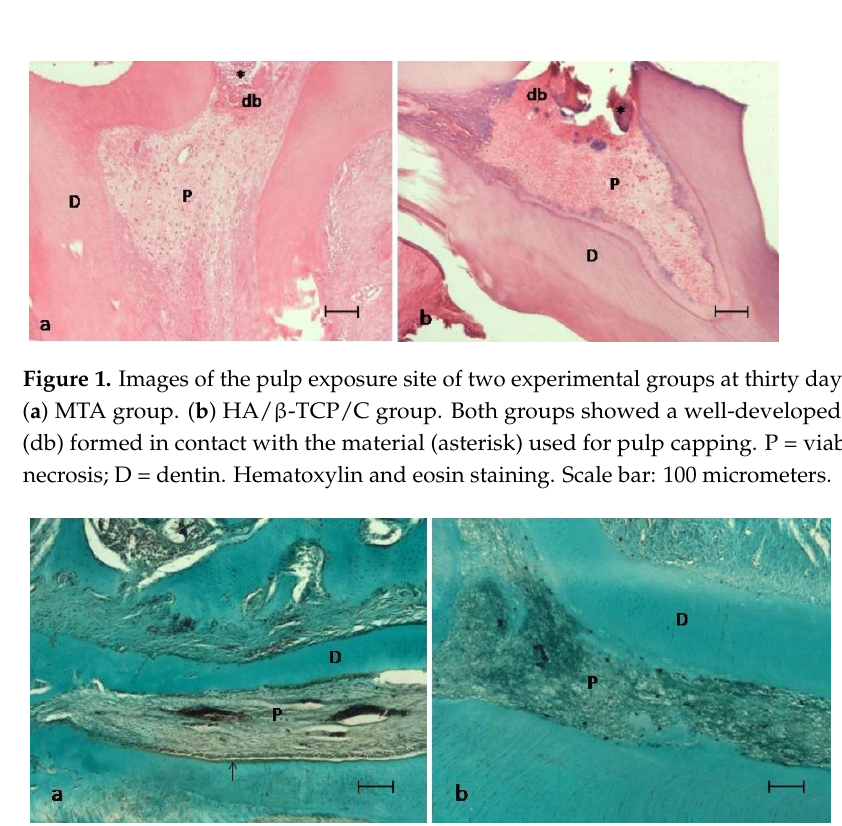
Figure 2. Images of a root canal at thirty days post-treatment. P = viable pulp without necrosis; D = dentin. ( a ) MTA group showed an intact odontoblastic layer (arrow) ( b ) HA/β-TCP/C showed fibrosis along the root canal. Masson’s trichrome staining. Scale bar: 100 micrometers. In the experimental group treated with HA/ β -TCP/C, 16 teeth were also